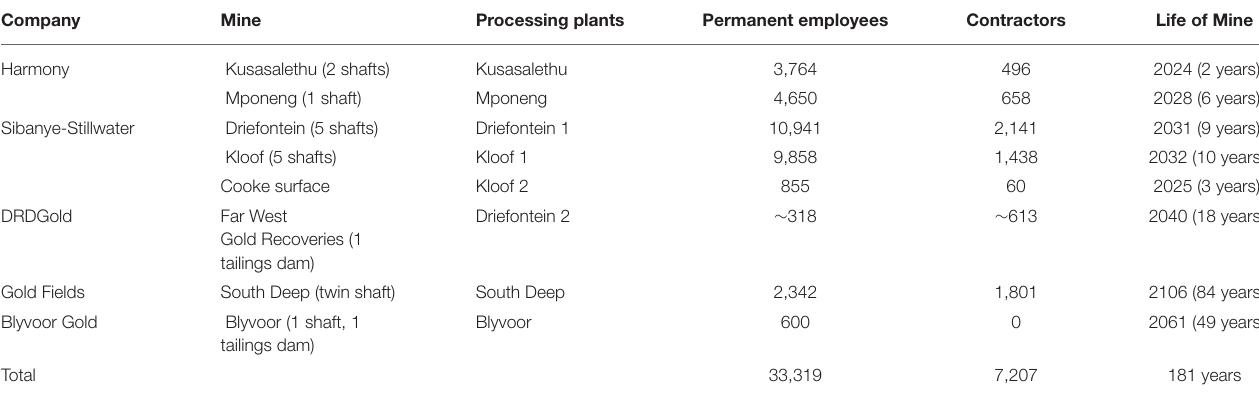
Company Mine Processing plants Permanent employees Contractors Life of